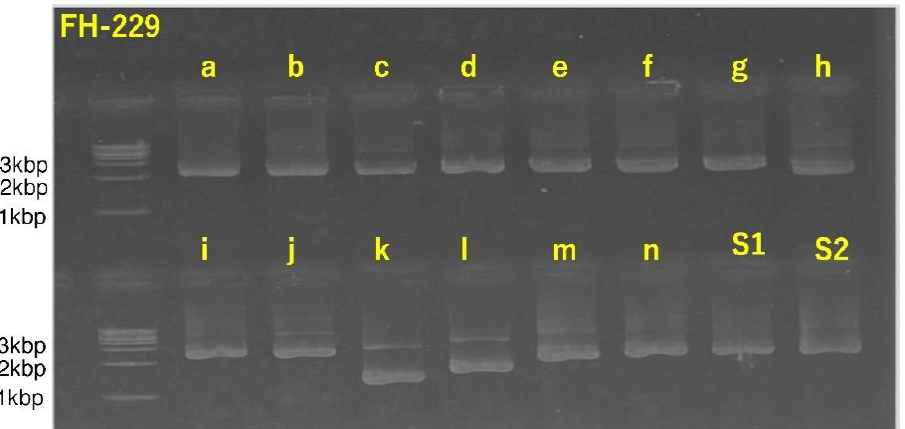
Figure 4. Positive amplification of each segment of SARS-CoV-2 full-length genome from 2nd nested RT-PCR verified by electrophoresis. RT-PCR products of each primer set were described with their respective name a to n, S1 and S2.